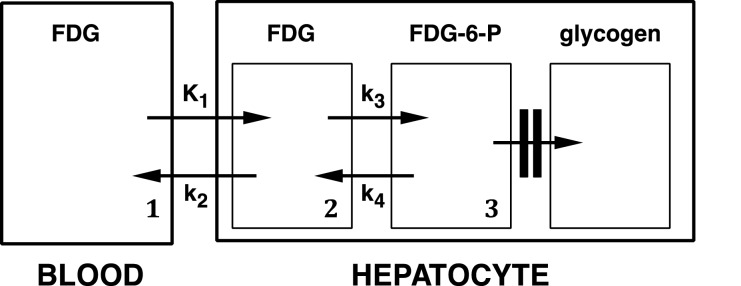
Model of FDG kinetics with reference to the liverK1 is hepatic blood flow, k2 is a diffusion constant, k3 is hexokinase and k4 is glucose-6-phosphatase. FDG is assumed to mix throughout its intrahepatic distribution volume (compartments 1 and 2) via K1 and k2 by 2 min post-injection. De-phosphorylation (via k4) in compartment 3 is assumed to be slow enough to ignore. Patlak–Rutland analysis therefore measures k3.